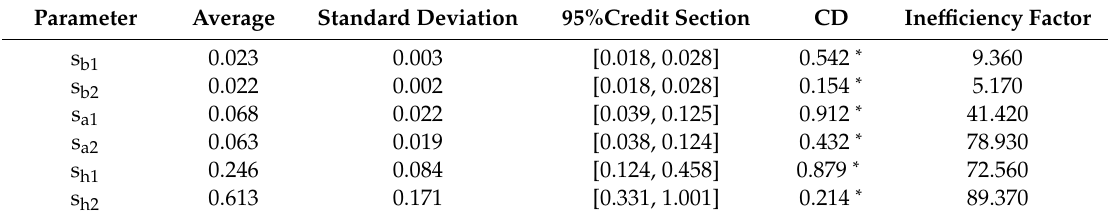
Table 6. Estimation results of the TVP-VAR model parameters on the JPY ( E2 t ,PL t , PJ t ) . Parameter